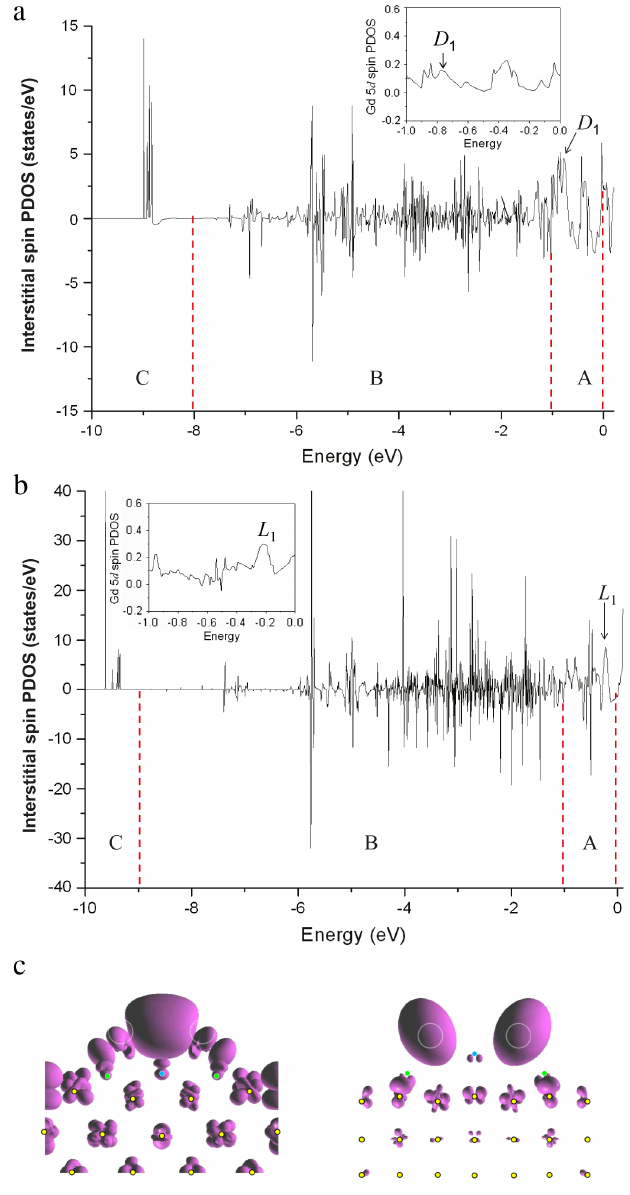
FIG. 6. (a) Spin-dependent partial density of states (S-PDOS) in the entire interstitial region of a ferromagnetic diagonal Gd- Ne-Gd dimer on CuN, defined as the majority-spin DOS minus the minority-spin in this spatial region. The plotted energy range is divided into three regions. Region A: The S-PDOS is mostly positive. The peak that dominates the S-PDOS is labeled D 1 . Region B: The S-PDOS is highly oscillating. Region C: A single positive peak at the energy of the majority-spin 4 f level. The inset shows the Gd 5 d S-PDOS in the energy range A. (b) Same plots as (a) for the linear Gd-Ne-Gd dimer. The dominating peak is labeled L 1 . (c) The majority-spin probability densities of the orbitals D 1 (left) and L 1 (right), viewed along the same orientation as the side view of the spin density of the diagonal and linear Gd-Ne-Gd dimers in Figs. 5(b) and 5(d), respectively. The open white circles indicate the muffin-tin spheres of the Gd atoms. The isosurfa- ces are plotted at the value of 0 : 02 a (cid:3) 3 0